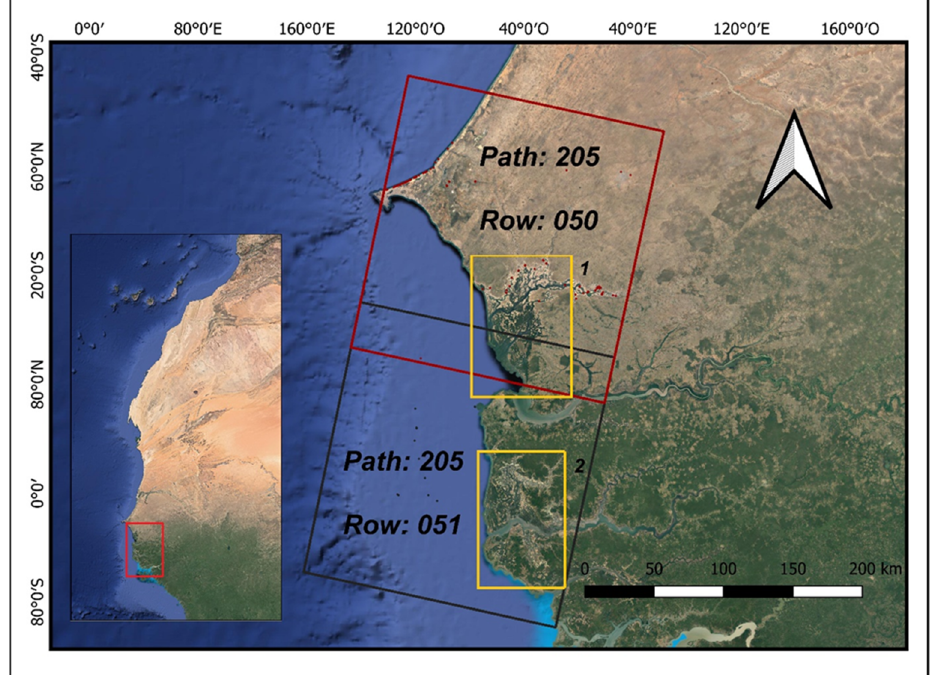
Figure 1. Location of mangroves in the Saloum delta (1) and Casamance estuary (2) and areas of study. The red and black rectangles represent the spatial extent of the Landsat. The yellow rectangles represent the spatial extent of the two mangrove areas.